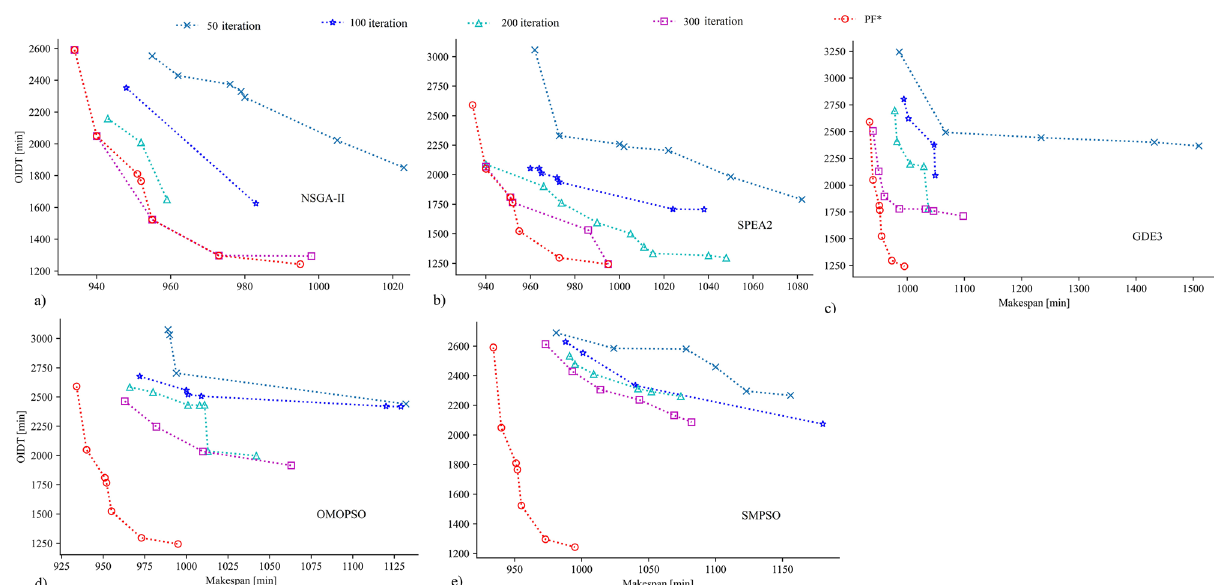
Figure 10. Improvement of candidate Pareto fronts (PF) for BK50 over different iteration size obtained by ( a ) NSGA-II, ( b ) SPEA2, ( c ) GDE3, ( d ) OMOPSO and ( e ) SMPSO. A label of 50 iteration indicates the front is obtained by and algorithm with 50